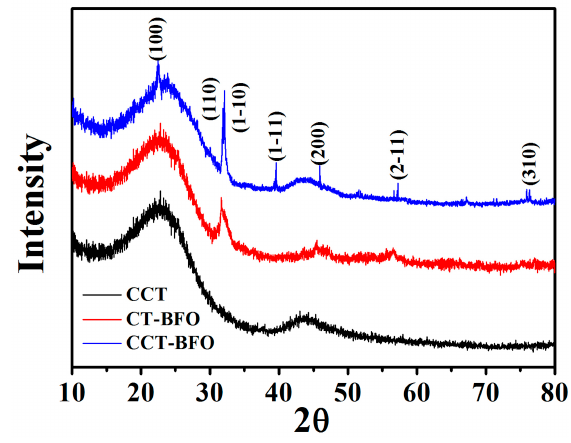
Figure 1. X-ray diffraction (XRD) patterns of the CCT, CT-BFO, CCT-BFO respective.